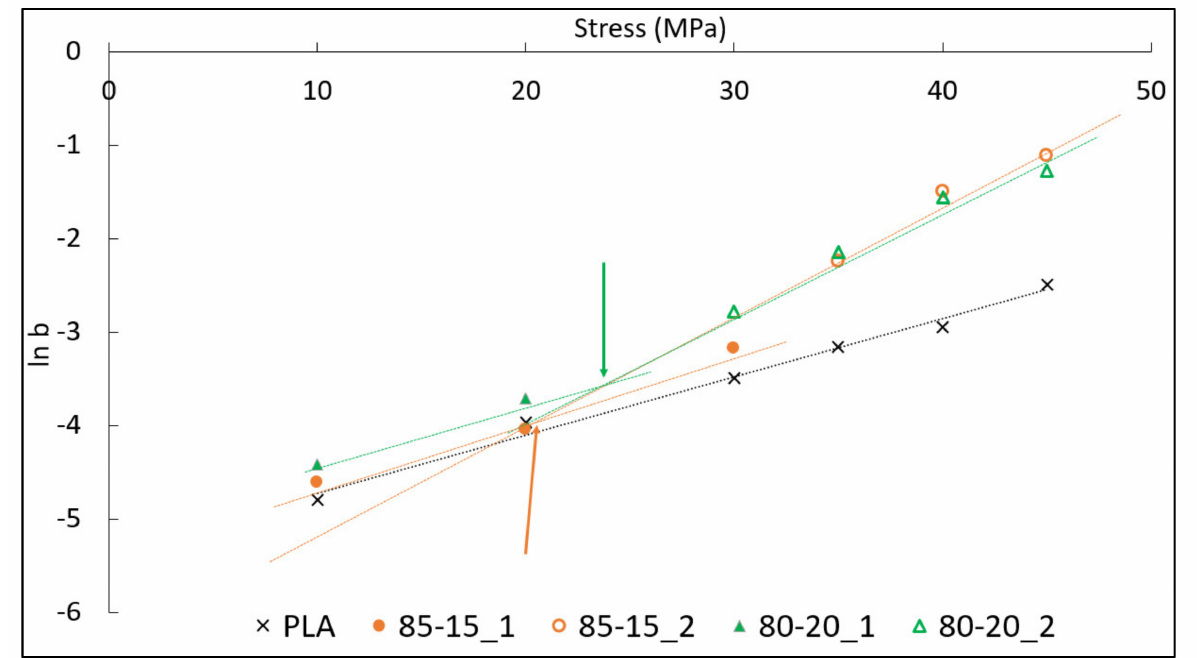
Figure 5. Andrade B parameter in which is highlighted the different slope changes between pure PLA and its blends (85-15 and